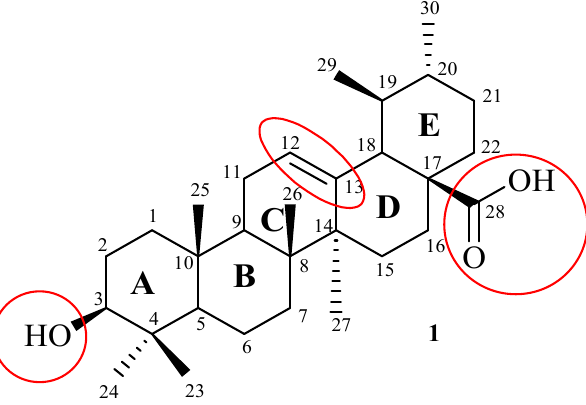
Figure 2. Structure of UA indicating the major active sites.